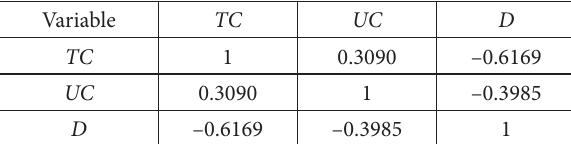
Table 3. Distribution functions Table 4. Fictive correlation matrix of the Nataf distribution